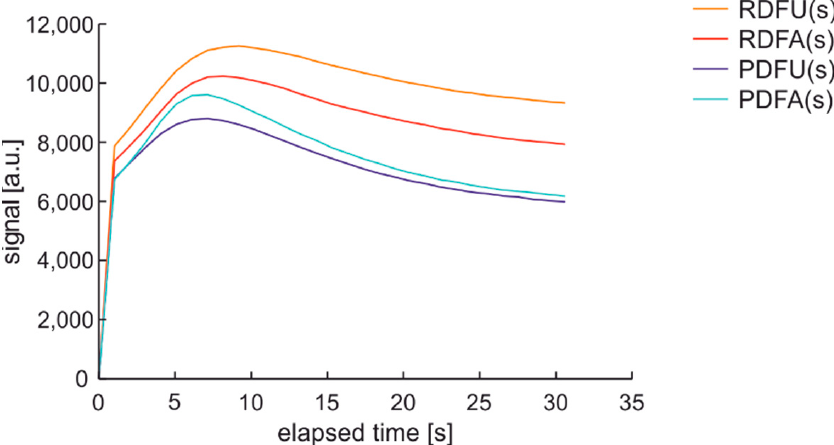
Figure 28. Time series at 490 nm of data of DHE:UVonTon cycle initiation.